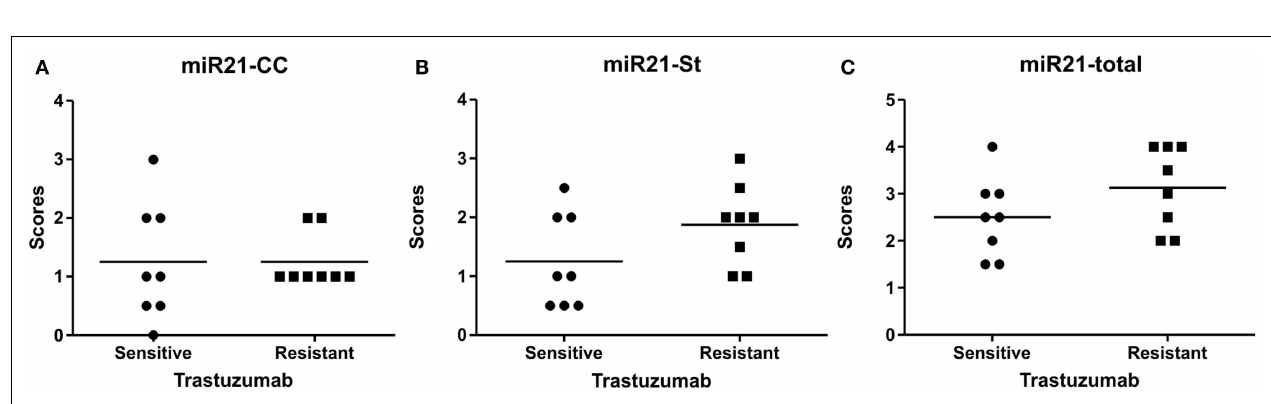
FIGURE 4 | MicroRNA-21 scores in the HER2 study group. The miR-21 scores for cancer cell-associated miR-21 expression, miR-21 CC (A) , miR-21 stromal expression, miR-21 St (B) , and the total summarized miR-21 scores